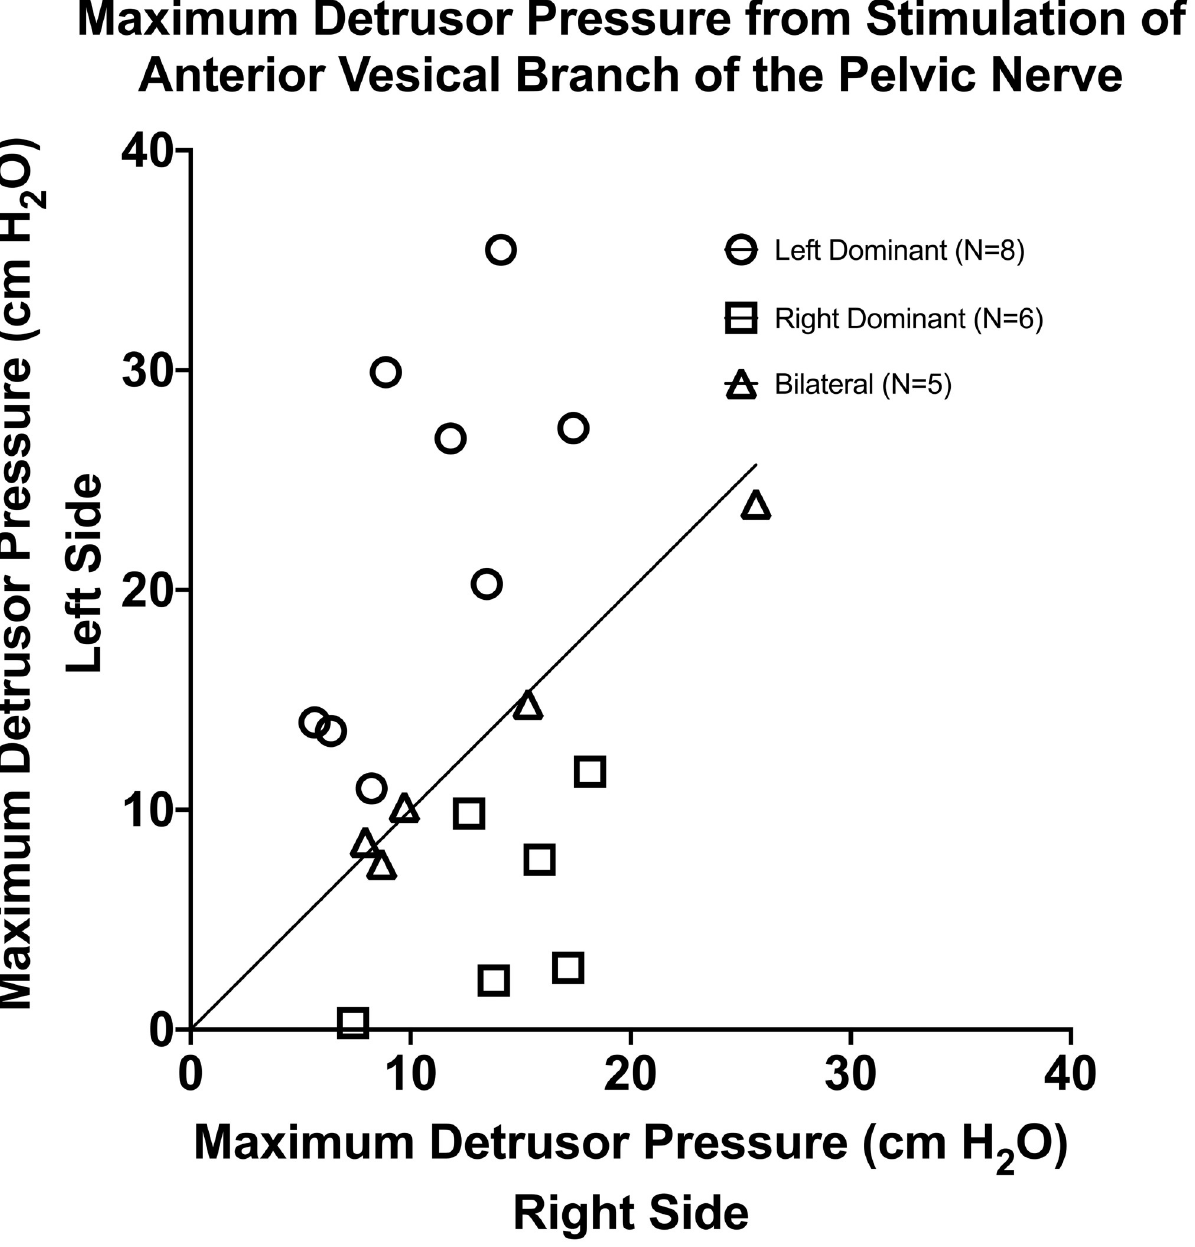
Fig 3. Maximum detrusor pressure after anterior vesical branch of the pelvic nerve stimulation. Maximal contractions produced from electrical stimulation of the anterior vesical branch of the pelvic nerve roots were recorded during the initial surgeries in 19 dogs (6 of which were part of the cohort tested at multiple levels). Left root- and right root-evoked contractions are displayed on the Y-axis and the X-axis, respectively. Each point represents the maximal contraction obtained from stimulation of either left or right pelvic nerve root in a single animal, whichever produced the strongest bladder contraction. N = number of dogs, cmH 2 O = centimeter of